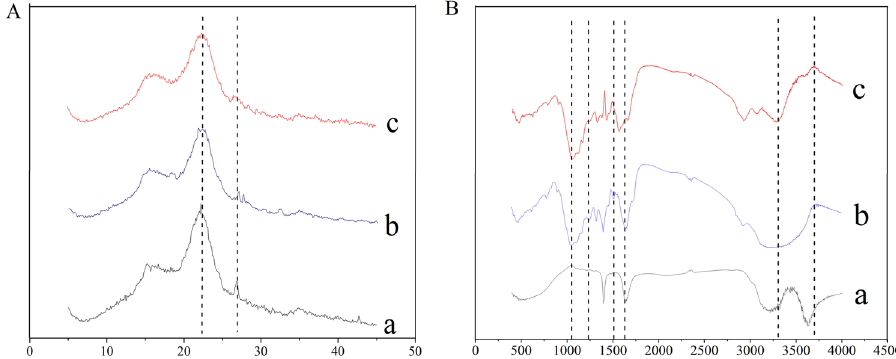
Figure 6. XRD and FTIR of untreated and bio-pretreated corn stover. ( A ) Stands for XRD; ( B ) stands for FTIR; a stands for untreated corn stover; b stands for bio-pretreated corn stover with P . C .; c stands for bio-pretreated corn stover with M . V .